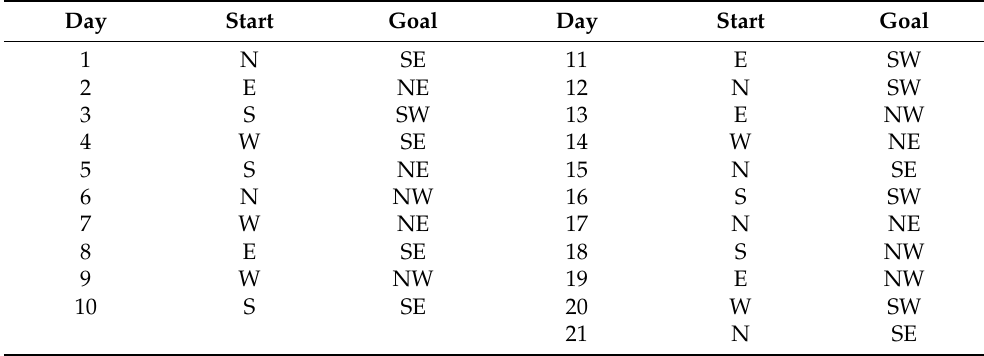
Table 3. Scheme of Morris water maze experiment for the study of working memory with an indication of starting point and goal